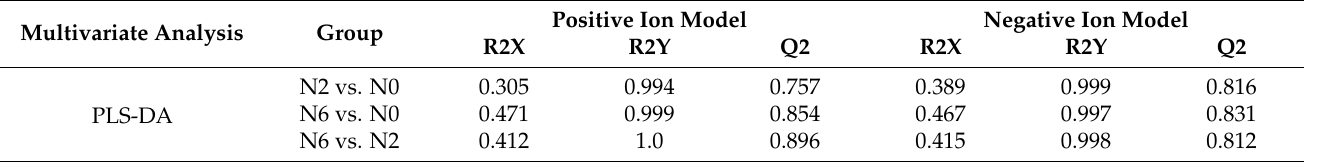
Table 2. The parameters of multivariate analysis of brown rice under different nitrogen levels. Multivariate